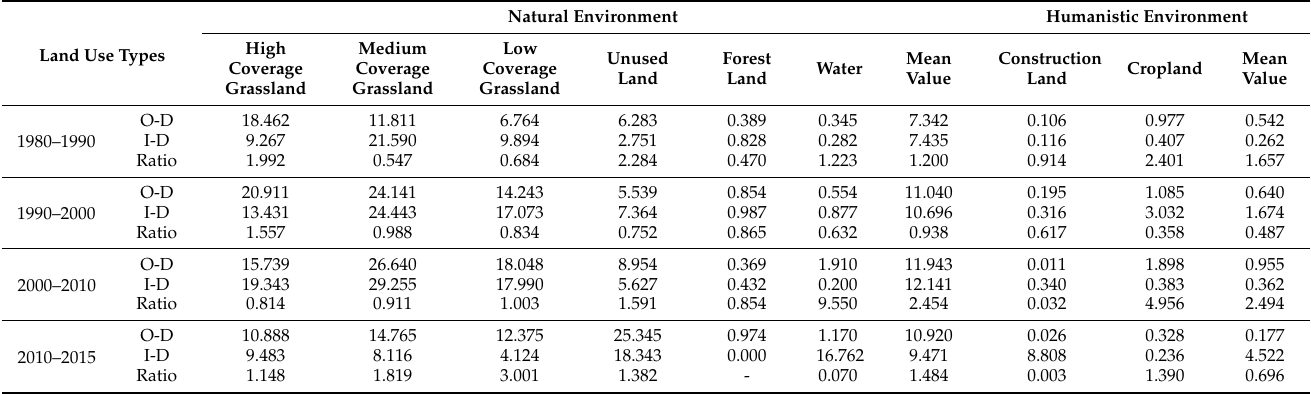
Table 3. Degree distribution of nodes in transfer matrix networks in different